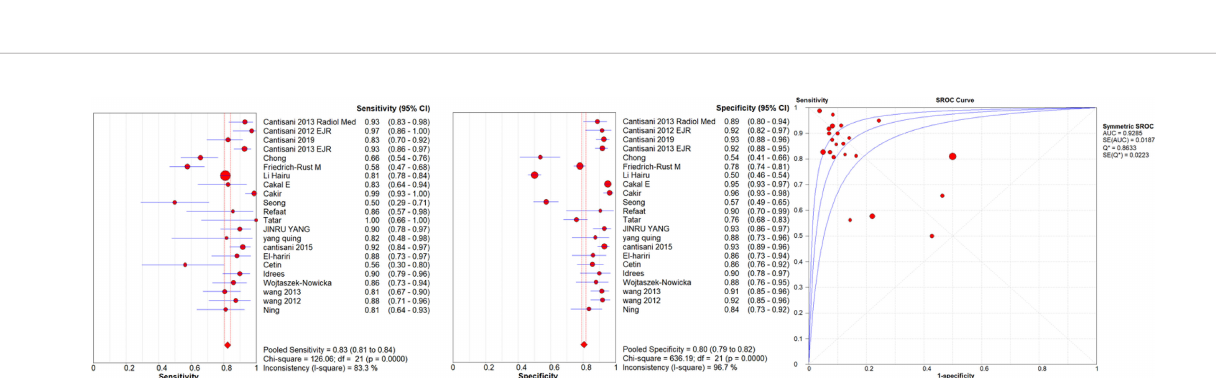
FIGURE 1 | Sensitivity and speci fi city forest plots and SROC curve for the qualitative USE. The circle size represents the nodule population of the selected articles; the line represents the con fi dence interval of the selected articles.